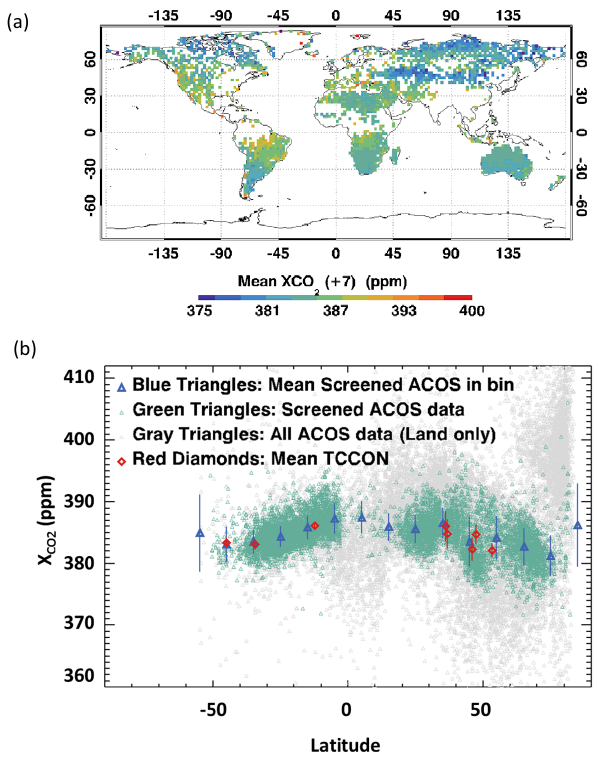
Fig. 12. (a) Map of all ACOS GOSAT B2.8 XCO2 soundings over land for July 2009 that passed all pre- and post-screening fil- ters. (b) The ACOS GOSAT B2.8 X CO estimates shown in Fig. 1 2 have been divided by 0.982 to remove the global component of the bias and improve their agreement with contemporaneous TC- CON retrievals.